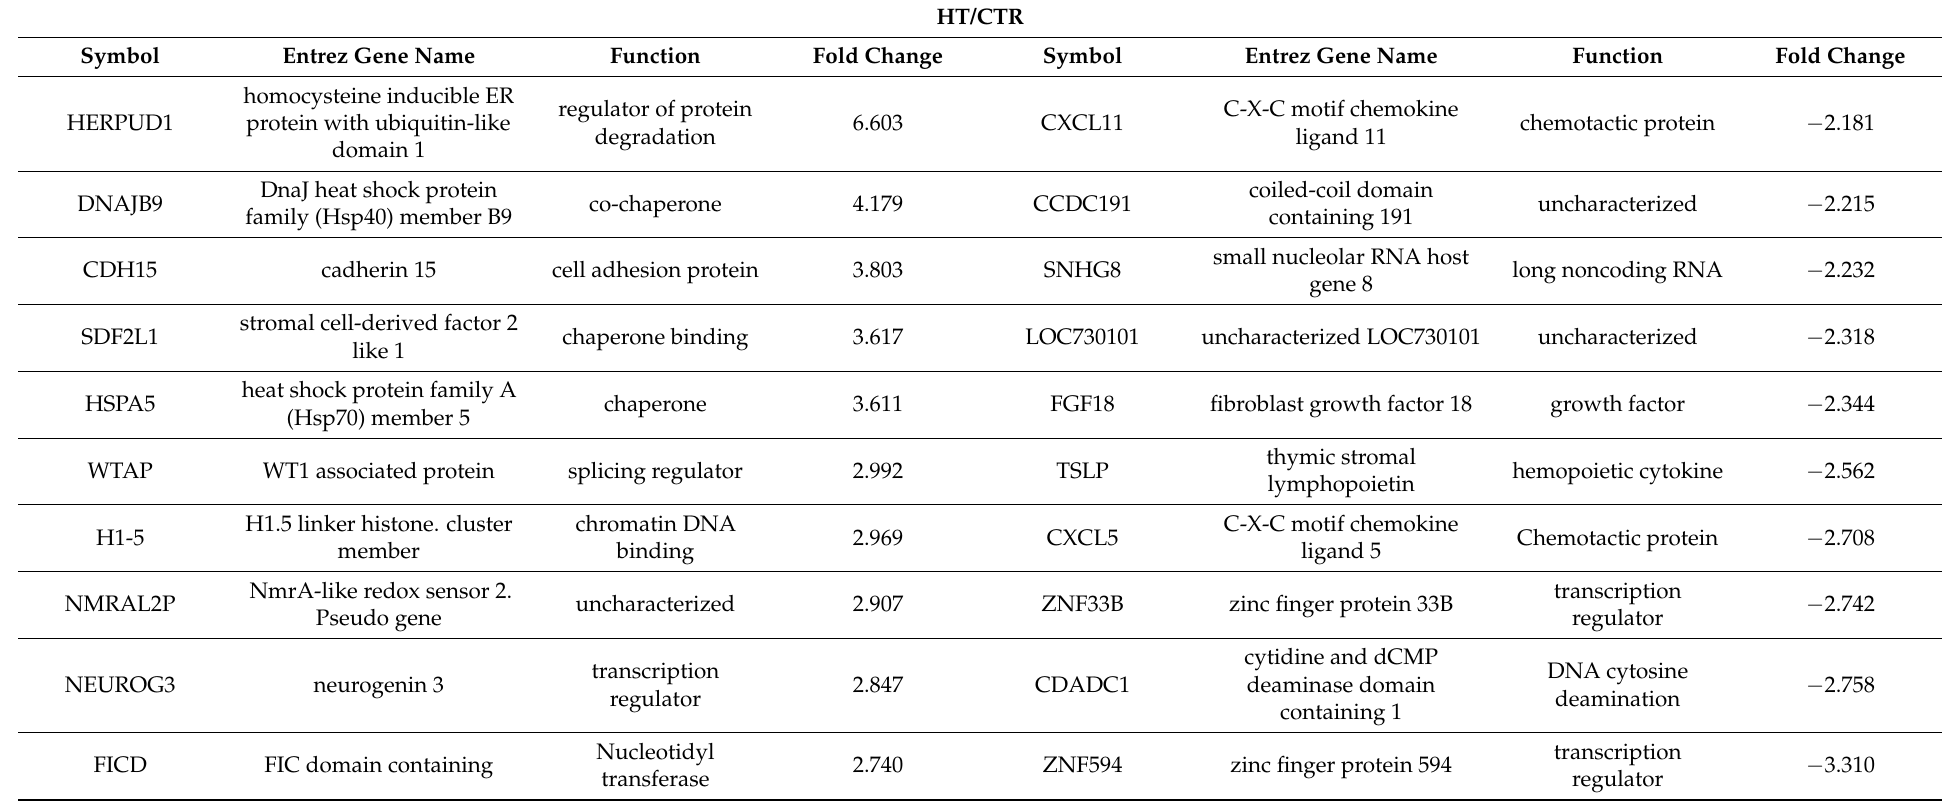
Table 3. The top 10 up-regulated or down-regulated genes by HT in endothelial cells at basal condition